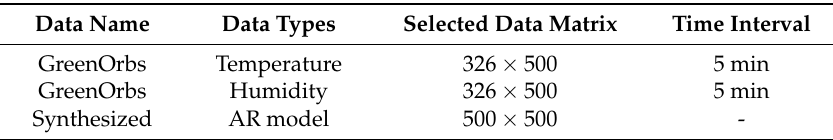
Figure 1. The real deployment topology of GreenOrbs. Table 2. The experimental datasets.